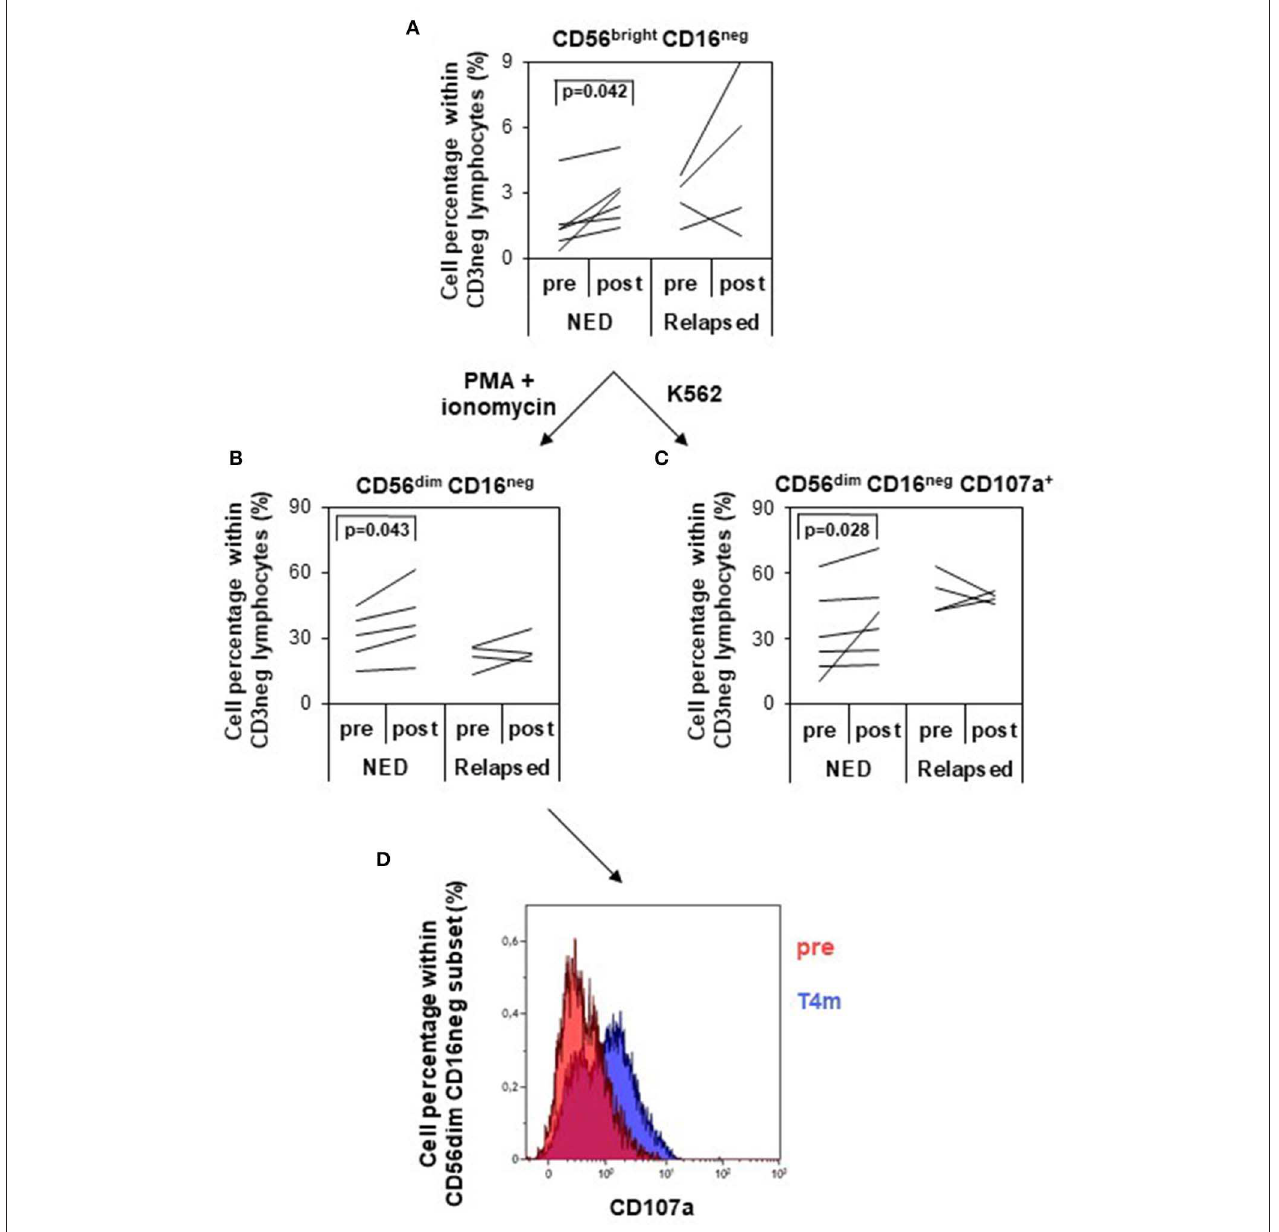
FIGURE 5 | Analysis of natural killer (NK) cell subsets and of their functionality. NK cells were identified and divided into four different subsets based on the expression of CD56 and CD16 within the CD3 negative lymphocytes (gating strategy depicted in Supplementary Figure S2 ). (A) Variation of the percentage of CD56 bright CD16 neg NK cells (logarithmic scale) between pretreatment and posttreatment (4 months) in patients with no evidence of disease (NED) ( n = 6) vs. relapsed patients ( n = 4). (B,C) NK cells were in vitro cultured with PMA/ionomycin (B) or with K562 target cells (C) , and CD56 dim CD16 neg NK cells were analyzed for their percentage variation (B) and CD107a expression (C) pretreatment and posttreatment in NED ( n = 6) and relapsed patients ( n = 4). p values by Wilcoxon signed-rank test. (D) Functional analysis of CD56dim CD16neg NK cells in response to K562 target cells pretherapy and 4 months after therapy in one representative patient (patient 28). CD107a-positive cells increased after